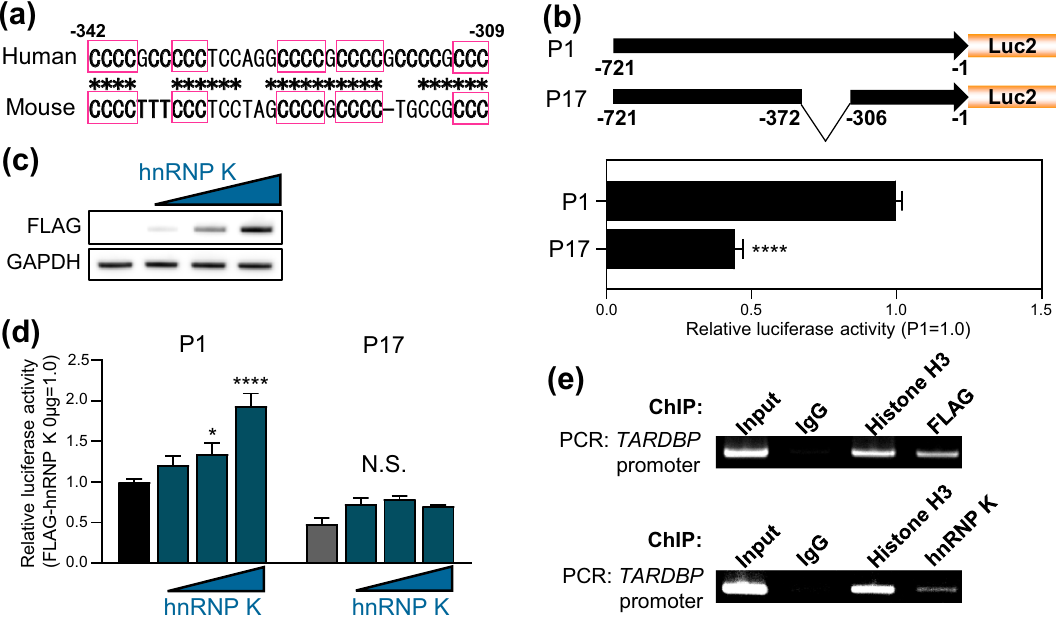
Figure 6. hnRNP K regulates the TARDBP promoter via the predicted i-motif region. ( a ) Conservation of C-rich sequences in predicted i-motif regions between humans and mice. The squares and asterisks indicate C-rich and conserved sequences, respectively. ( b ) Schematic representation and luciferase assay of the TARDBP promoter construct with deletion of the predicted i-motif (P17). n = 6 replicates; Welch’s t-test relative to P1. ( c ) Immunoblot analysis of FLAG-hnRNP K overexpression in HeLaS3 cells. ( d ) Luciferase assay of P1 and P17 promoter activity with dose-dependent hnRNP K overexpression. Each reporter plasmid was co-transfected with 0, 0.5, 1 and 2 μg of hnRNP K/pFLAG-CMV2. n = 3 replicates; two-way ANOVA with post hoc Dunnett’s test relative to 0 μg of hnRNP K/pFLAG-CMV2. All samples transfected 2 μg of reporter vector and 2 μg of pFLAG-CMV2 vector (empty vector + hnRNP K). All error bars indicate the means ± SEMs. * P < 0.05, **** P < 0.0001. ( e ) ChIP assay of overexpressed FLAG-hnRNP K (top) or endogenous hnRNP K (bottom) binding to the TARDBP promoter in HEK293T cells. Immunoprecipitation was performed using anti-FLAG antibody (for overexpressed FLAG-TDP-43) or anti-hnRNP K antibody (for endogenous hnRNP K), then PCR was conducted using primer detecting TARDBP − 721 to − 431 (290 bp). Control IgG and Histone H3 antibody are used for negative or positive control for